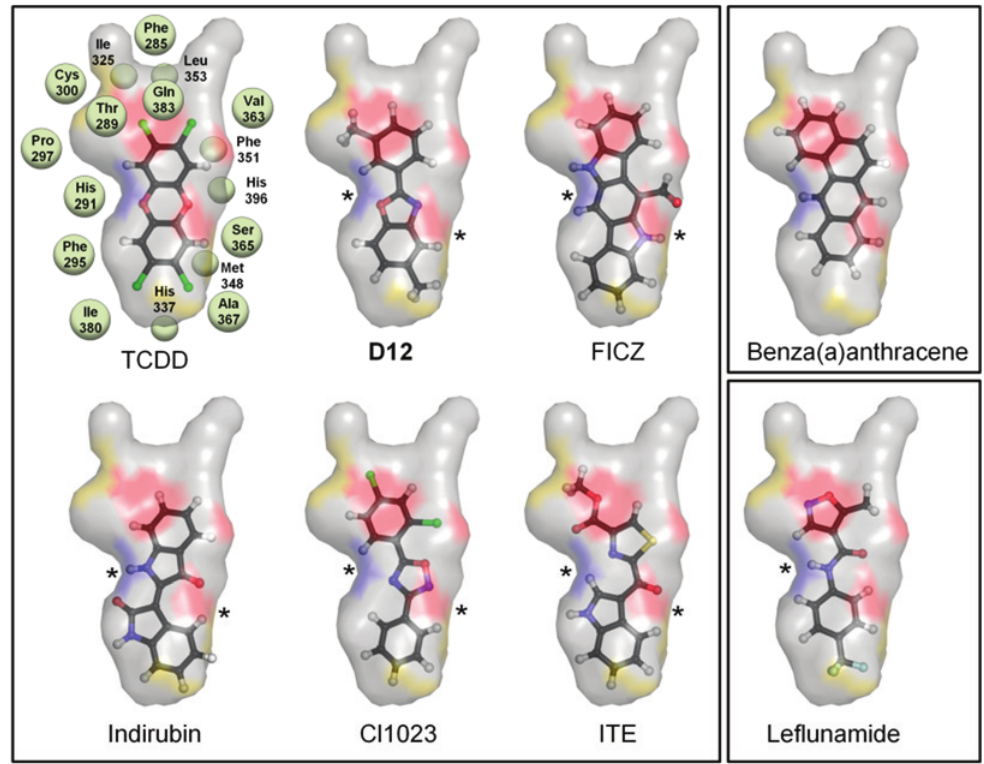
Figure 3. Binding pattern of AHR agonists. The top-scoring poses of selected AHR agonists docked into the agonist-optimized model are shown, with the pocket surface area contributed by the protein shown as transparent surface and calculated as in Figure 2. Atoms are colored by type (hydrogen-white, carbon-grey, oxygen-red, nitrogen-blue, sulfur-yellow, halogen-green). The residues constituting the pocket are indicated as grey spheres for TCDD. Some compounds shown docked in a TCDD-like manner, with the ability to form hydrogen bonds to both His291 and Ser365 (left panel, hydrogen bonds denoted with *). Leflunomide (bottom right panel) docked in a similar position but is only able to form a hydrogen bond with His291. Benza(a)anthracene (upper right panel) is apolar and so cannot form hydrogen bonds to these residues. We note that although Thr289 and Gln383 also contribute a polar region to the binding pocket, only 2-(1'H-indole-3'-carbonyl)-thiazole-4-carboxylic acid methyl ester (ITE) and Leflunomide docked with polar groups that could possibly form hydrogen bond interactions to these